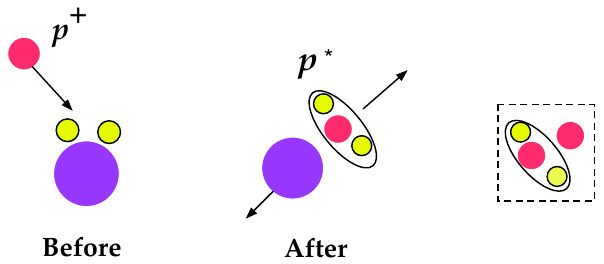
Fig. 2. A illustration showing a formation collision of a proton (in red) and an O 2 − ion (in purple), the latter having two unbound elec- trons (in yellow). A PTM is illustrated in the box (see text for ex-